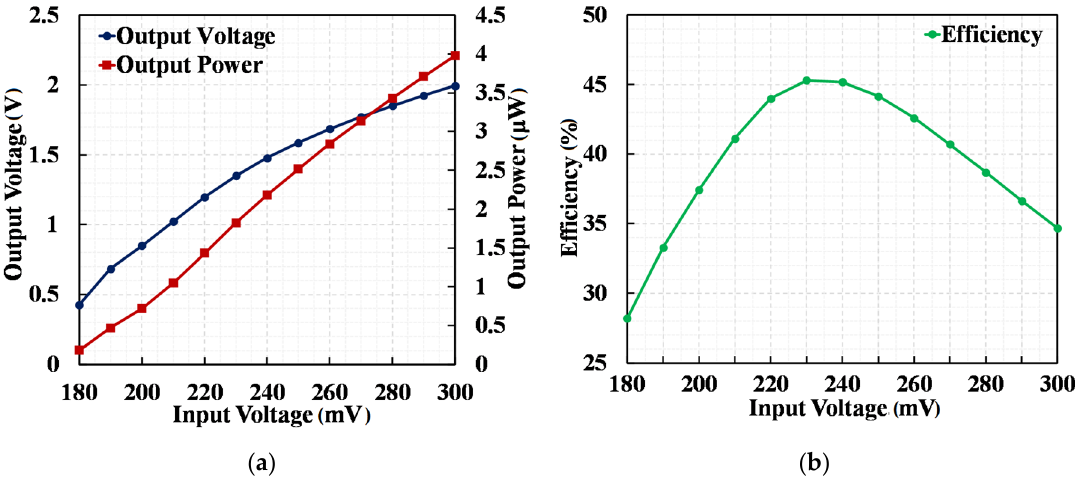
Figure 16. ( a ) Measured 𝑉 (cid:3016)(cid:3022)(cid:3021) and 𝑃 (cid:3016)(cid:3022)(cid:3021) versus 𝑉 (cid:3010)(cid:3015) @ 𝑅 (cid:3013) = 1 M Ω ; ( b ) measured efficiency versus 𝑉 (cid:3010)(cid:3015) . Figure 16. ( a ) Measured V OUT and P OUT versus V IN @ R L = 1 M Ω ; ( b ) measured e ffi ciency versus V IN .